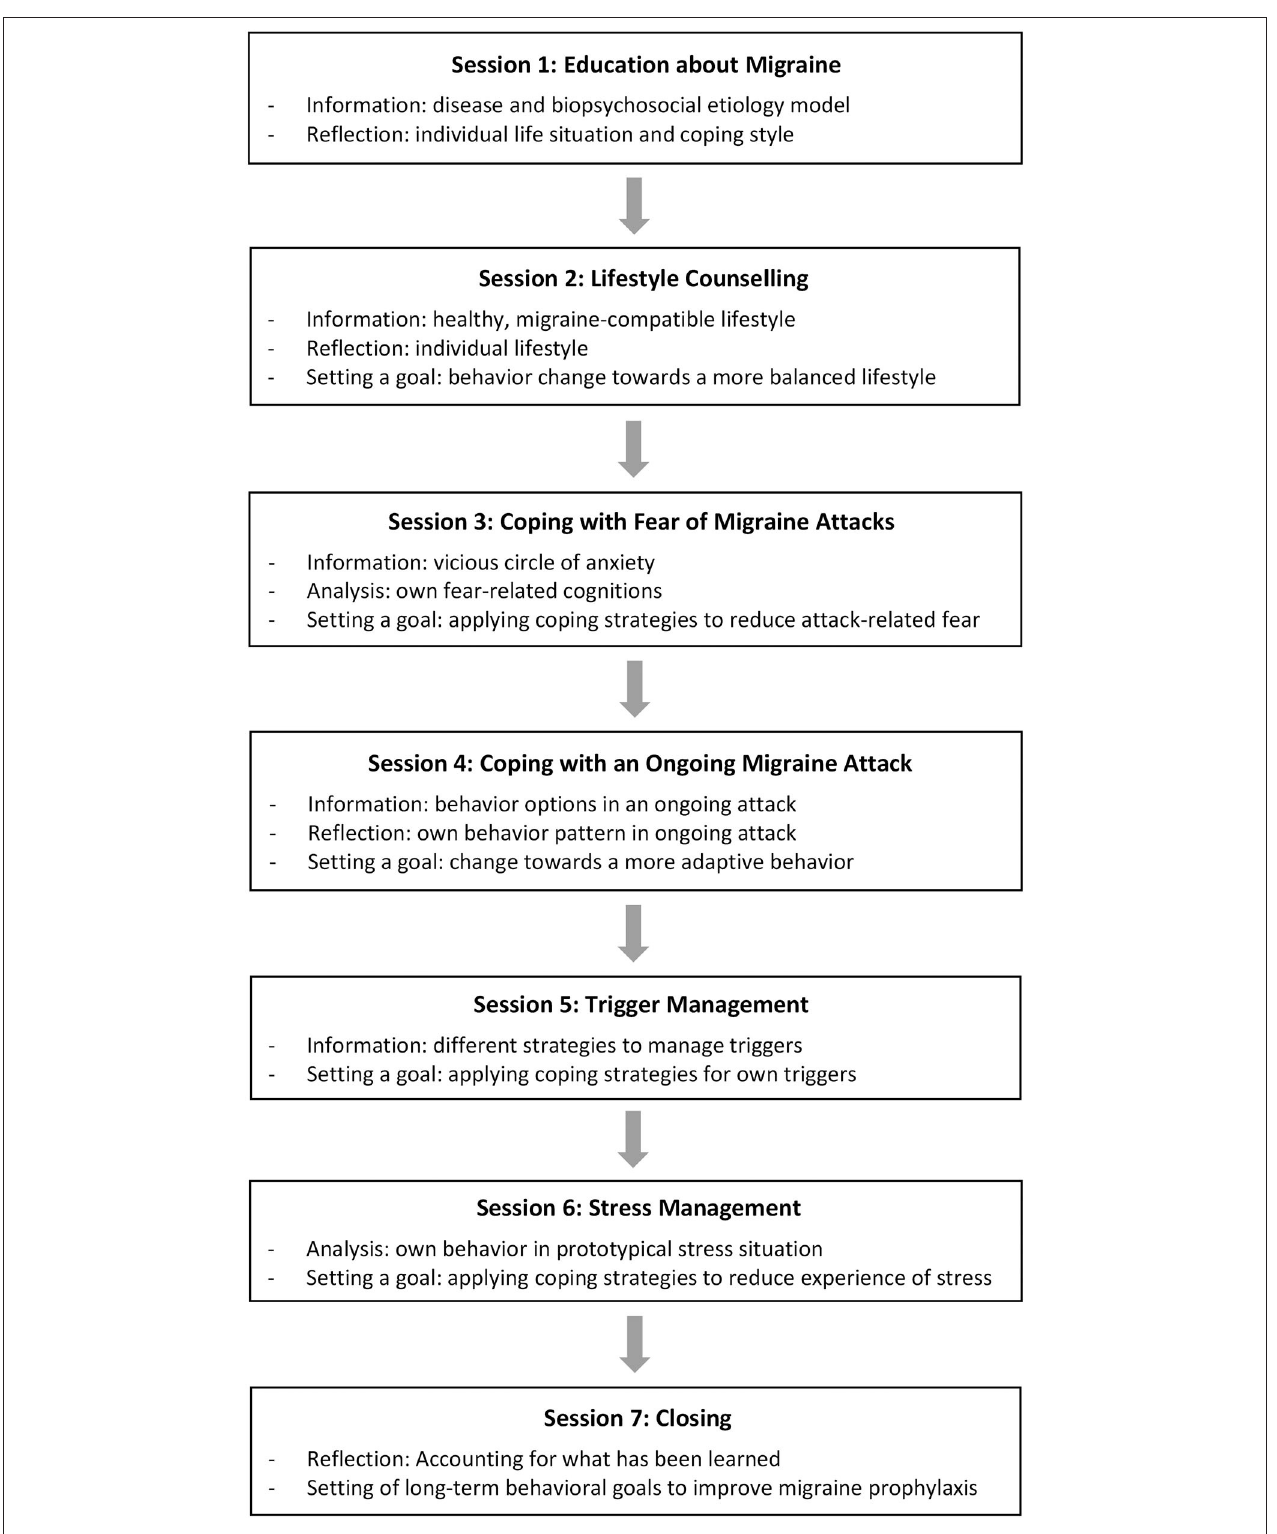
FIGURE 1 | Migraine-specific, integrative cognitive-behavioral therapy program (miCBT).